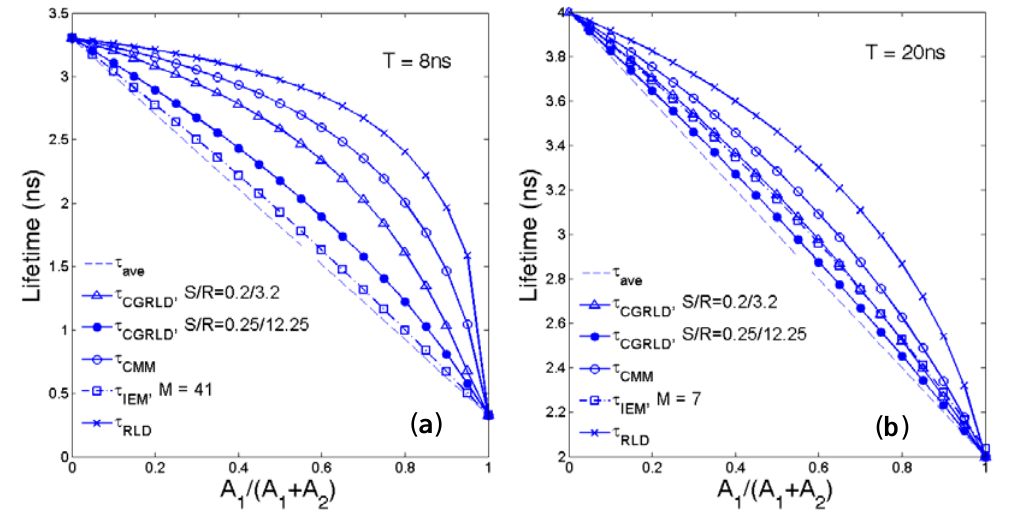
/( A + A ) plots obtained by different methods 1 1 2